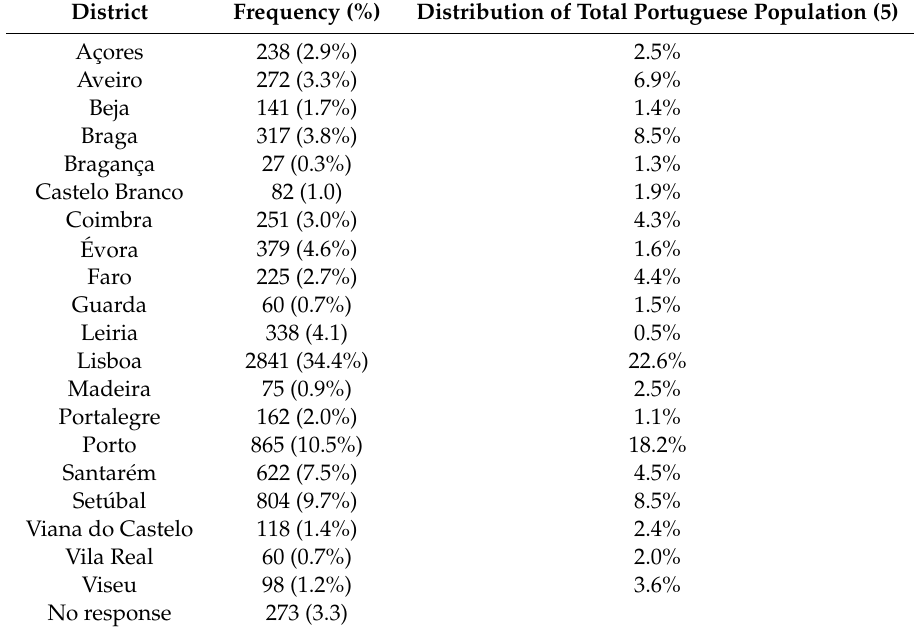
Table 2. Self-declared frequency (percentage) of questionnaires obtained from each Portuguese district and distribution of the total Portuguese population in the di ff erent